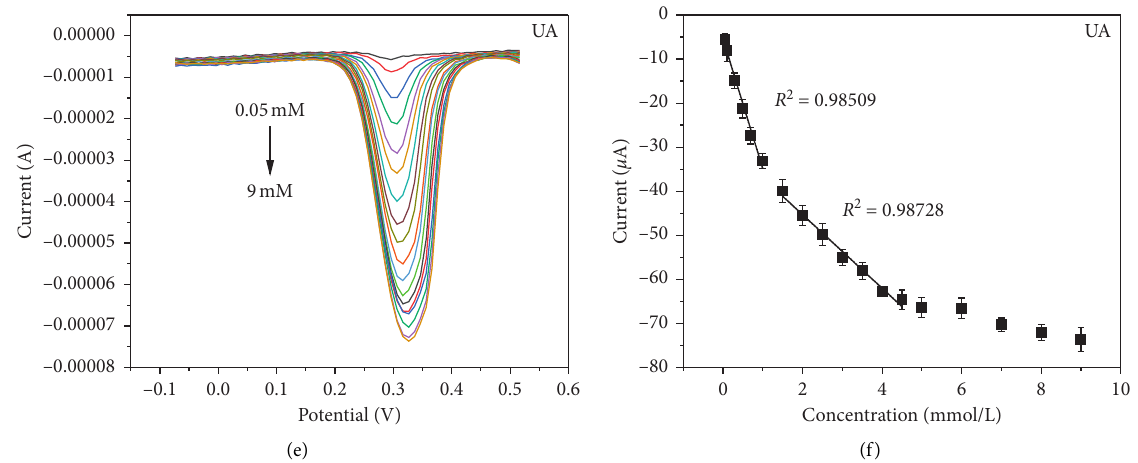
Figure 4: DPVs of different concentrations of (a) AA, (c) DA, and (e) UA on PdNPs/rGO/GCE in 0.1 MPB (pH 7.2); calibration plots for (b) AA, (d) DA, and (f)